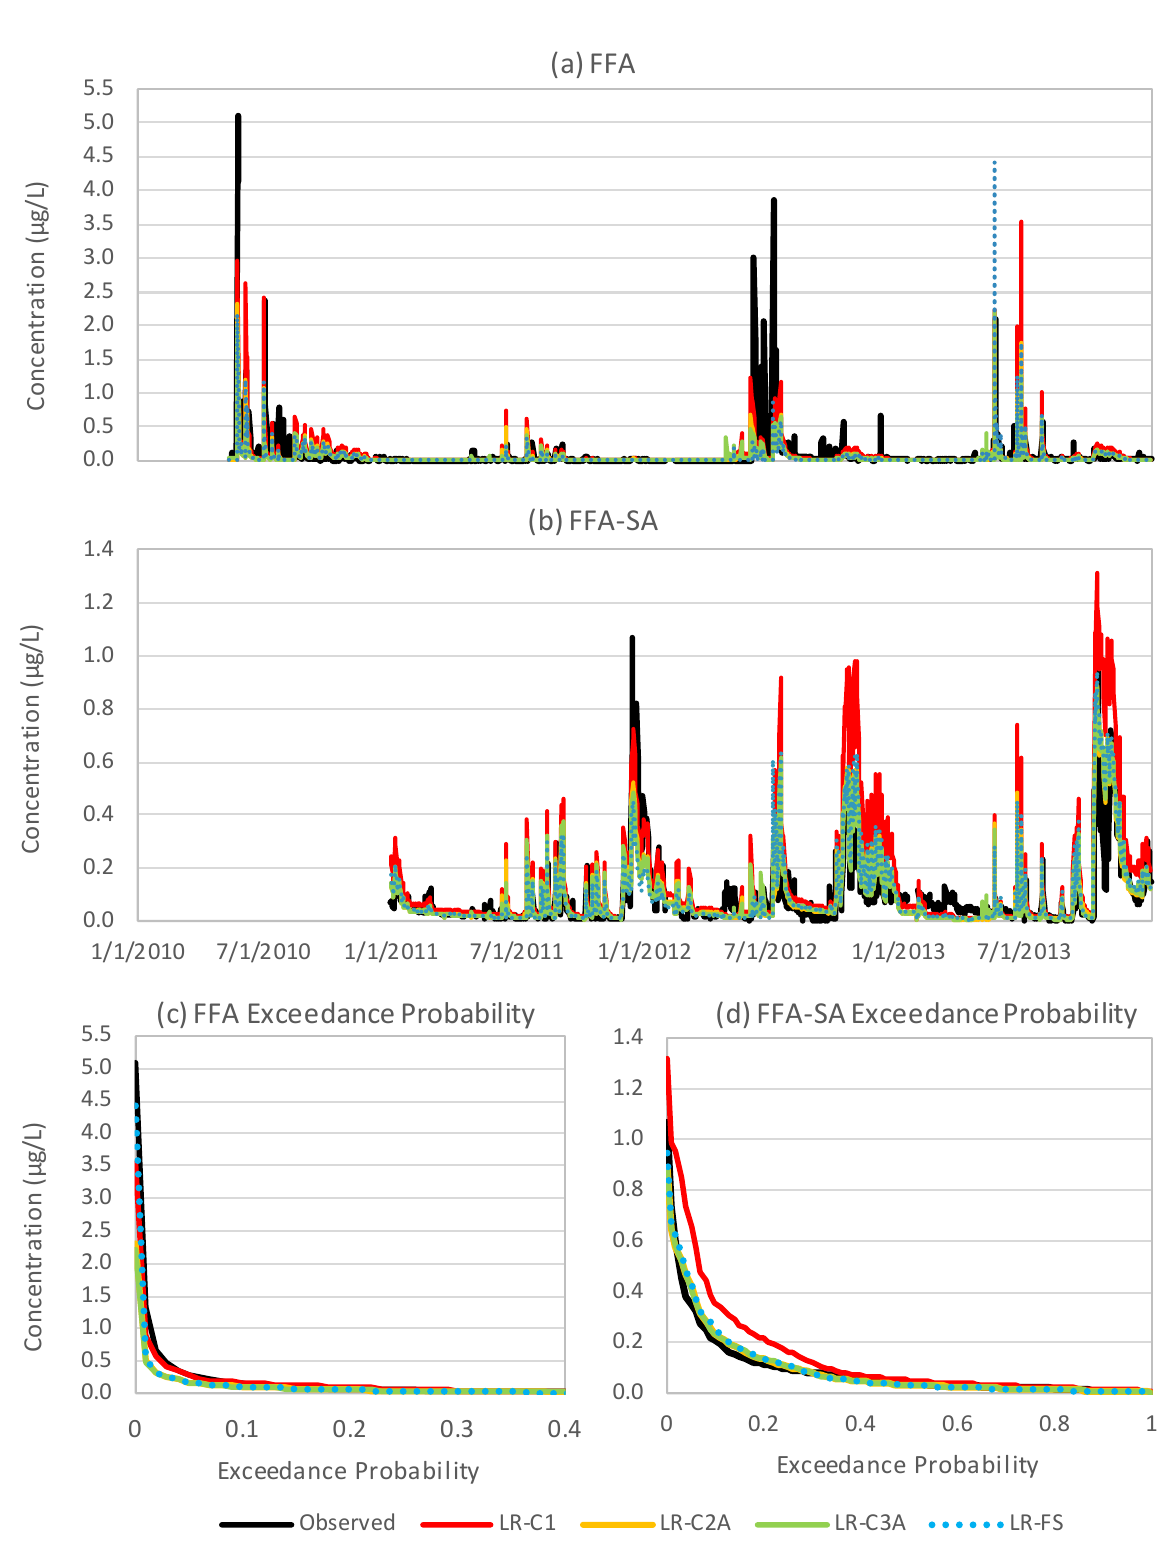
Figure 5. Comparison between observed, SWAT+ conditional management-based, and SWAT+ farmer survey-based ( a ) FFA concentrations, ( b ) FFA-SA concentrations, ( c ) exceedance probability of FFA concentrations, and ( d ) exceedance probability of FFA-SA concentrations.